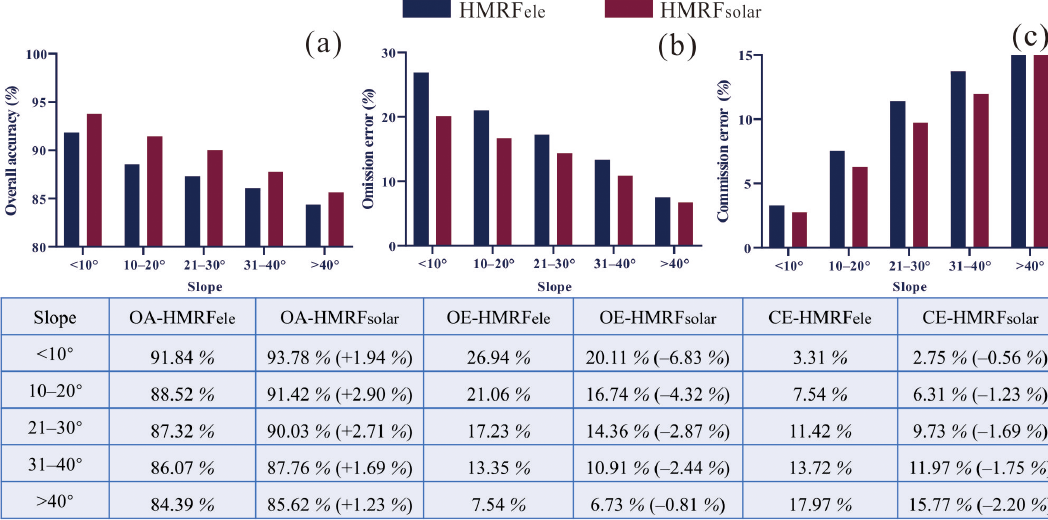
Fig. 8 (where the topography has a dominant effect on snow cover) show that the original HMRF ele -based snow cover products mapped all data gaps in the shaded and sunny slopes at the same elevation as snow-covered pixels; however, af- ter incorporating solar radiation, our new products accurately identified them as non-snow-covered pixels. In general, since sunny slopes receive relatively more solar radiation, the area of snow cover on sunny slopes is smaller than that on shaded slopes. The new HMRF solar -based snow products more effec- tively filled the data gaps on sunny slopes, producing more realistic results. Solar radiation was particularly effective as an environmental contextual factor to correct the snow detec- tion errors in mountainous